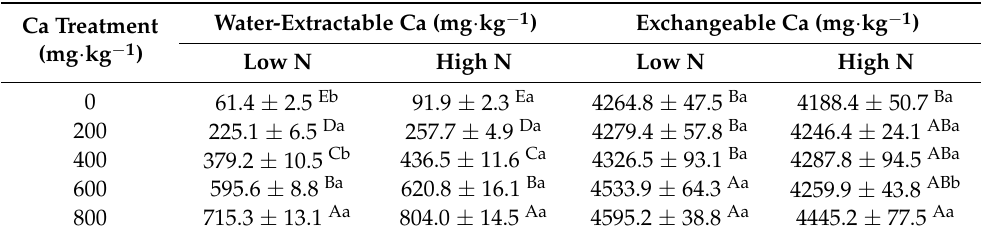
Table 3. Effect of different Ca and N treatments on water-extractable Ca and exchangeable Ca con- centrations in soil.